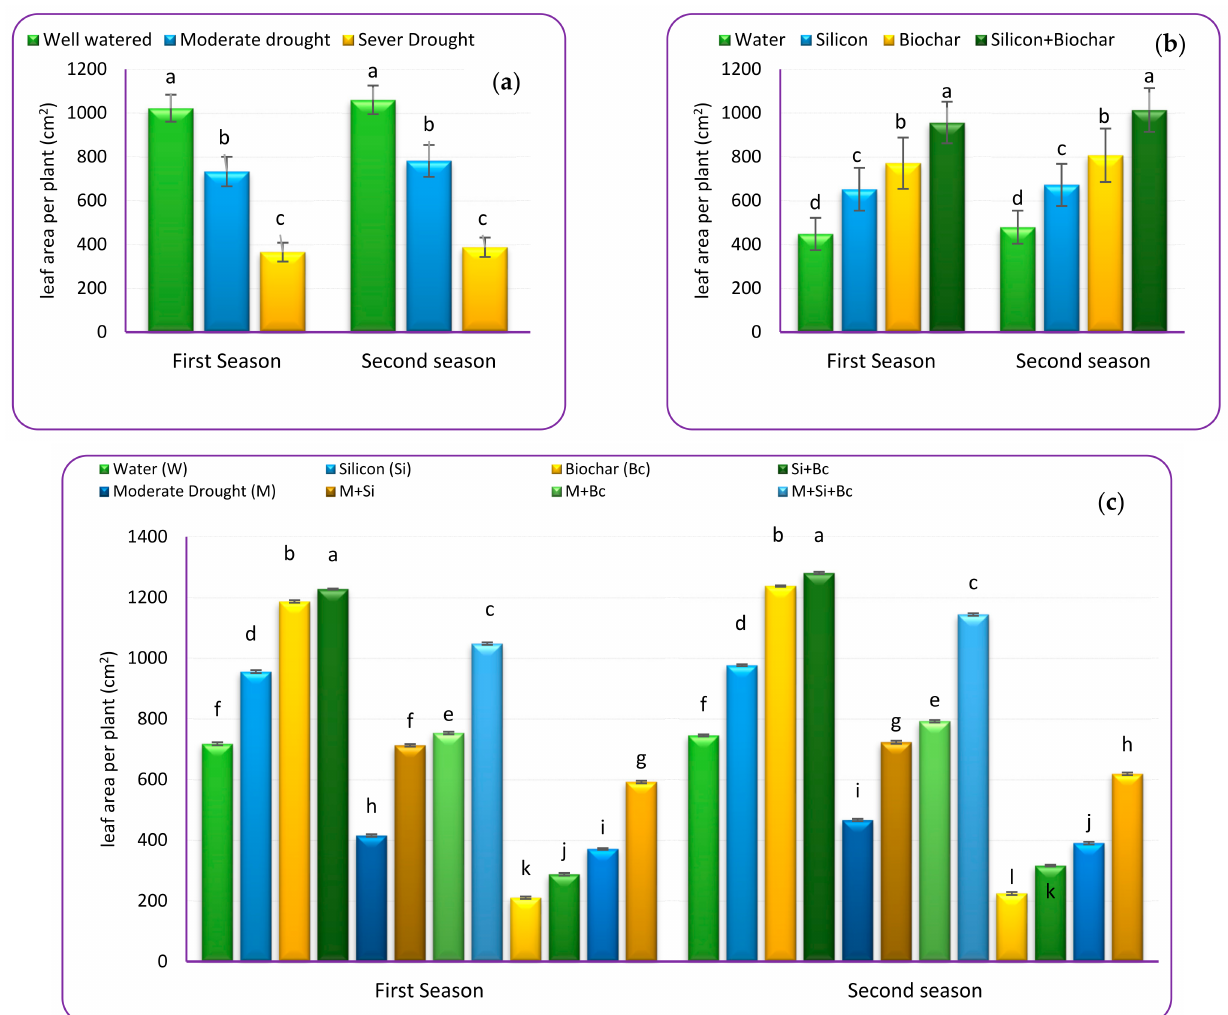
Figure 1. Effect of irrigation regimes ( a ), silicon, biochar ( b ) and their interaction ( c ) on leaf area (cm 2 ) per borage plant throughout two experimental years. Mean values ± standard error are inside each column for each trial, with equivalent letters meaning not significantly different following Tukey test at p ≤